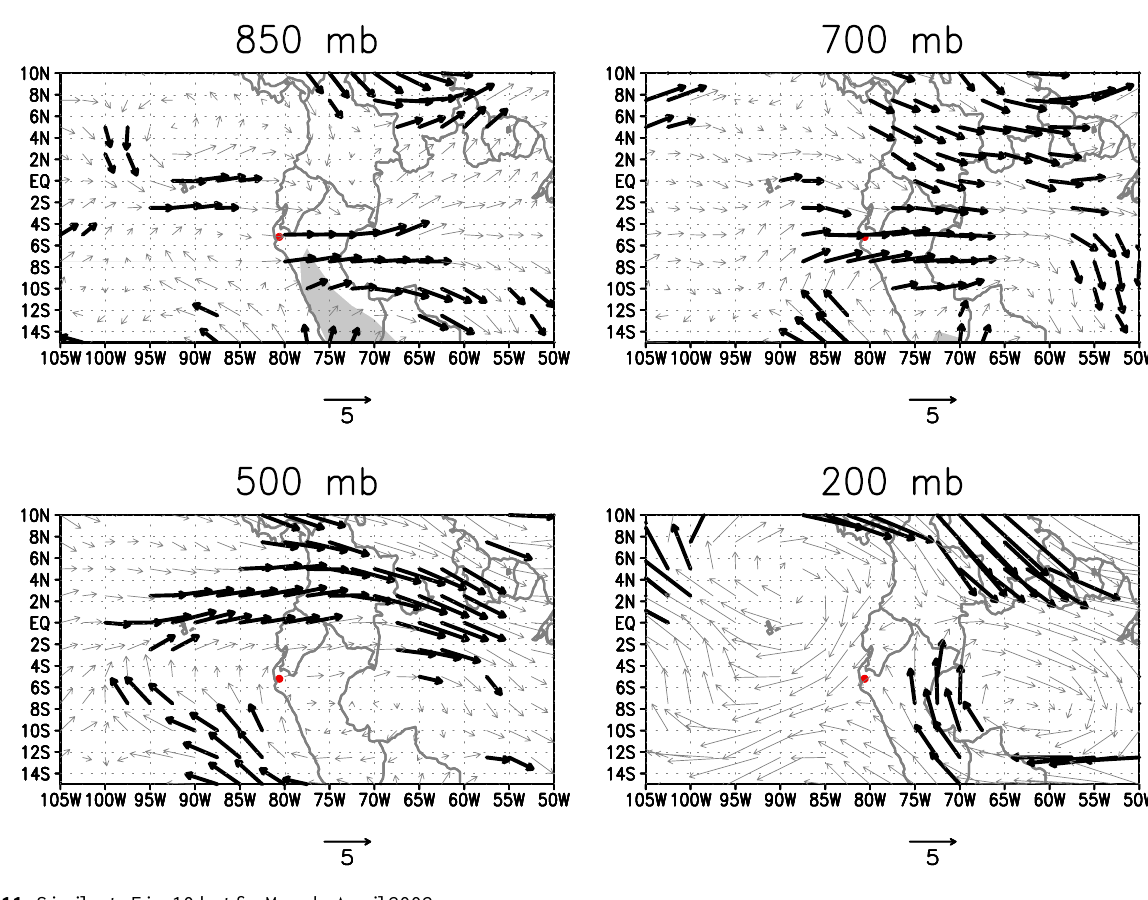
Fig. 11. Similar to Fig. 10 but for March–April